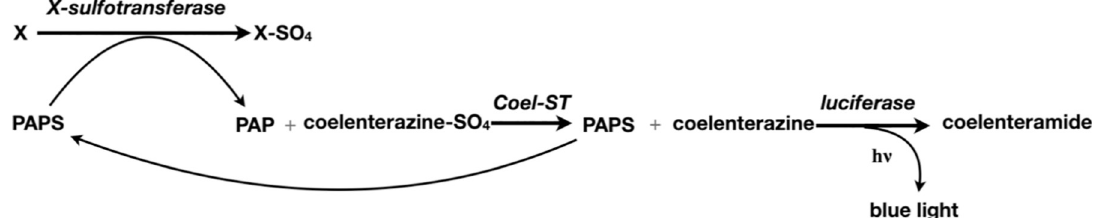
Fig 10. Generalized linked sulfotransferase